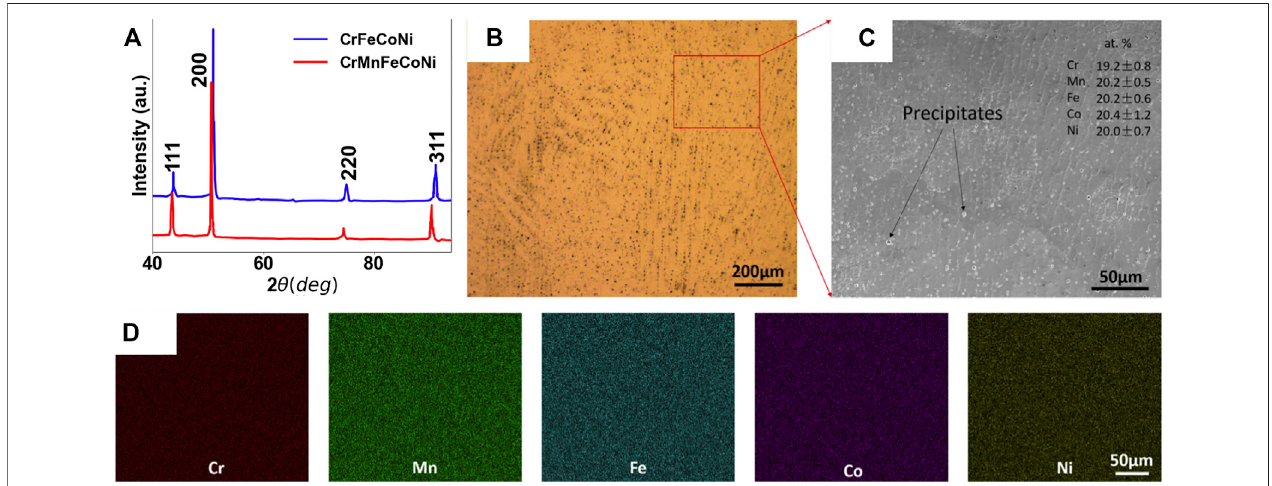
FIGURE4|(A) XRDplotsofCrFeCoNiandCrMnFeCoNiHEAsrepresentstheformationofasingle-phasesolidsolution(Wangetal.,2021), (B) Opticalmicrograph of CrFeCoNiMn HEA with a typical dendritic structure, (C) SEM image of CrFeCoNiMn reveals the presence of Cr and Mn-rich precipitates in the grains, (D) EDS map reveals a homogenous composition distribution of candidate elements in the alloy (Qiu et al.,